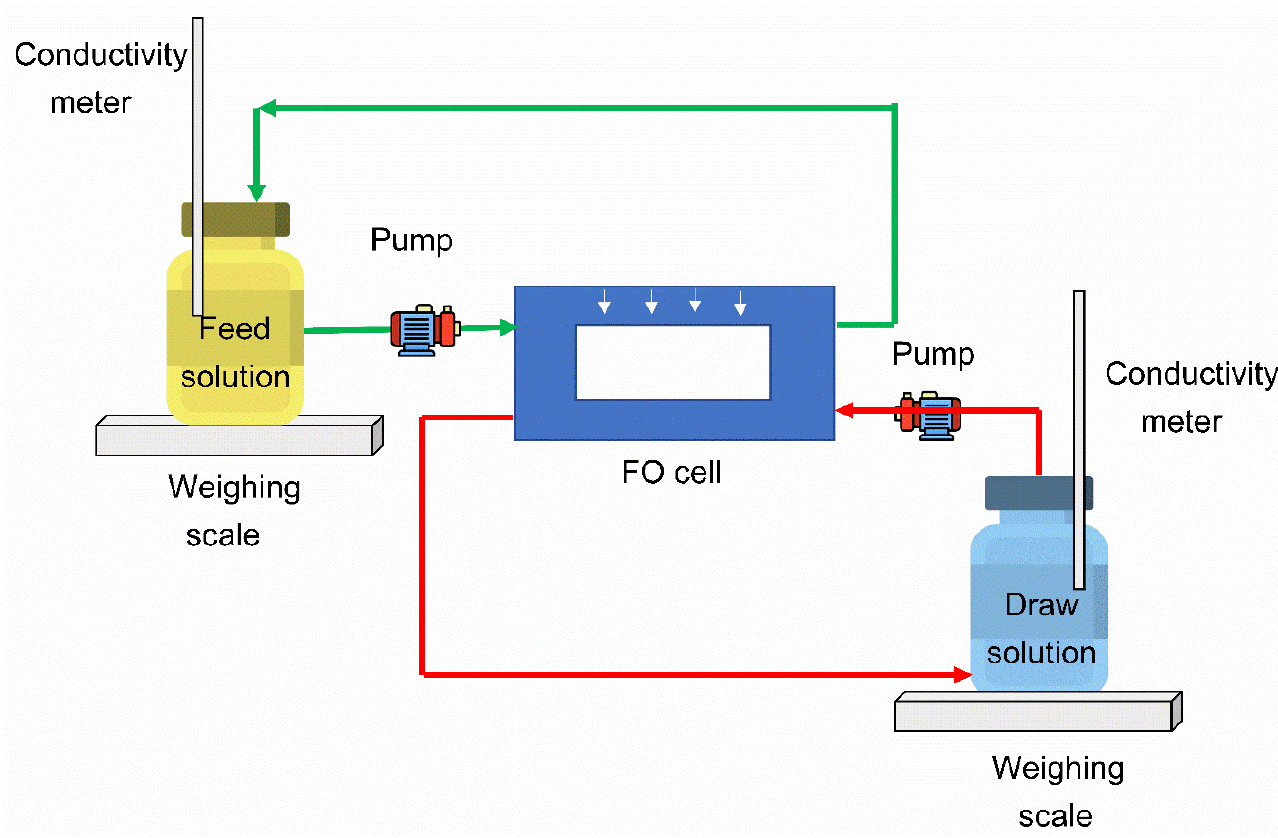
Figure 4. Schematic representation of the FO system.